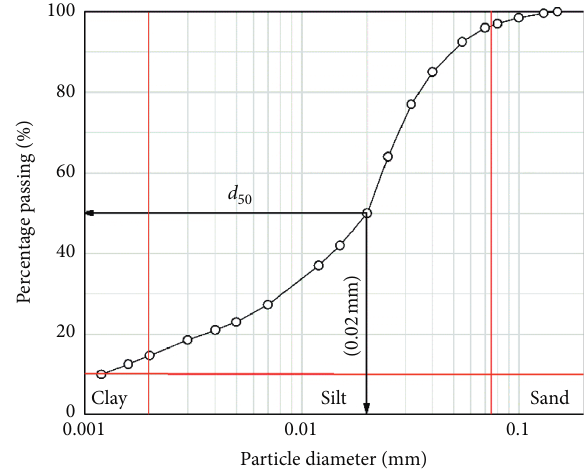
Figure 5: Particle-size distribution of Lishi